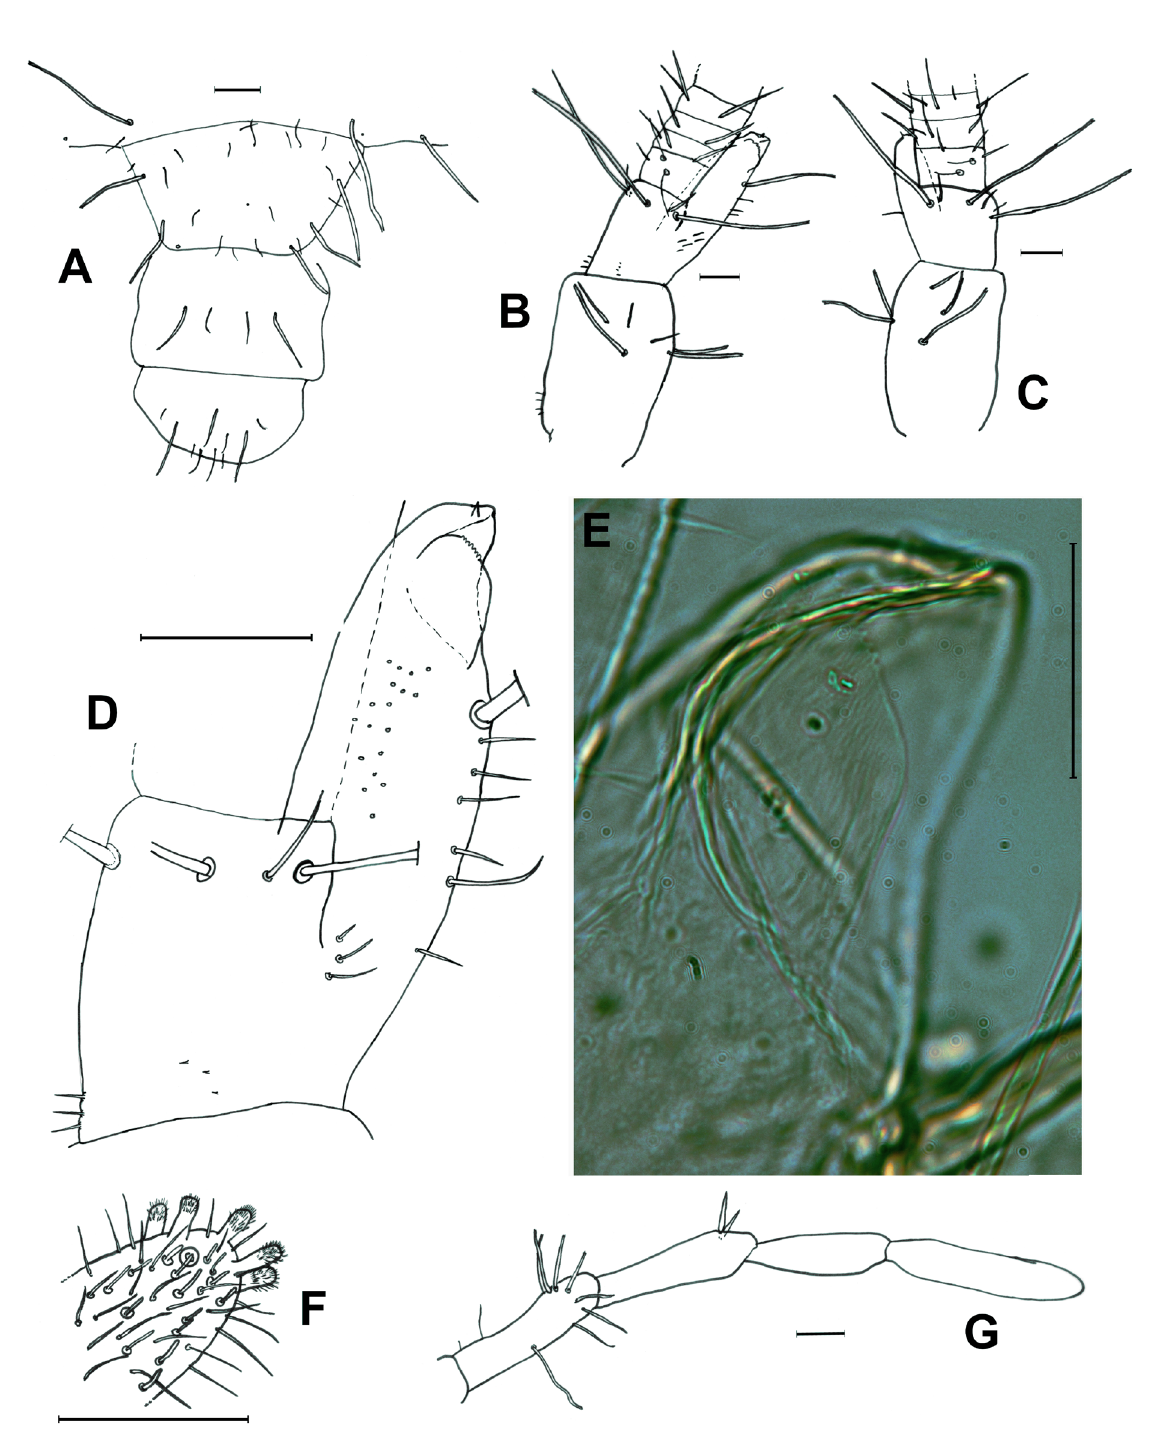
Fig. 9. Coletinia serrata Mendes, Molero-Baltanás, Bach de Roca & Gaju-Ricart sp. nov. Holotype, ♂ (MUHNAC, CZ-5646). A . Frons, clypeus and labrum. B . Left antenna: scapus, pedicel with apophysis and basal annuli of the flagellum. C . Idem of the right antenna. D . Detail of the apophysis of the left pedicel. E . Micrograph of the apical part of the apophysis of the left pedicel. F . Sensilla of the apical part of the last article of the maxillary palp. G . Maxillary palp. Scale bars: A, D, F–G = 0.1 mm; B–C = 0.2 mm; E = 50